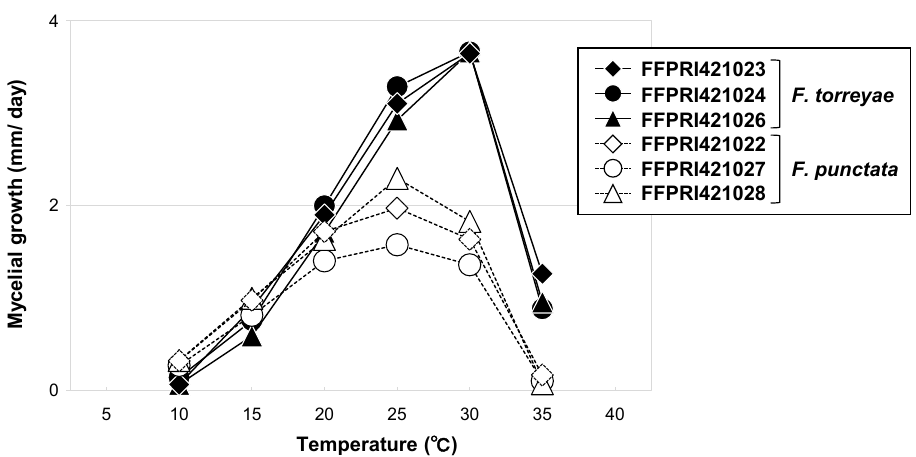
Figure 5. Mycelial growth of Fomitiporia torreyae and Fomitiporia punctata isolates at different temperatures. Values indicate means ( n = 3).